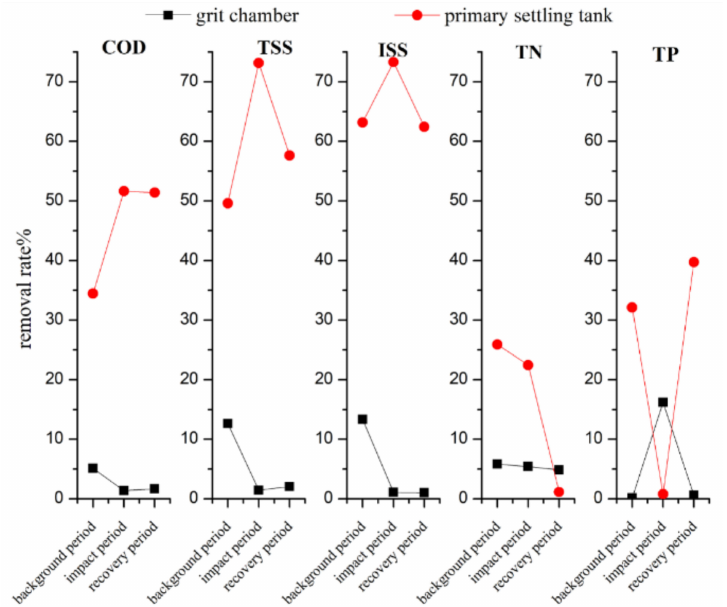
Figure 5. The removal rate of pretreatment